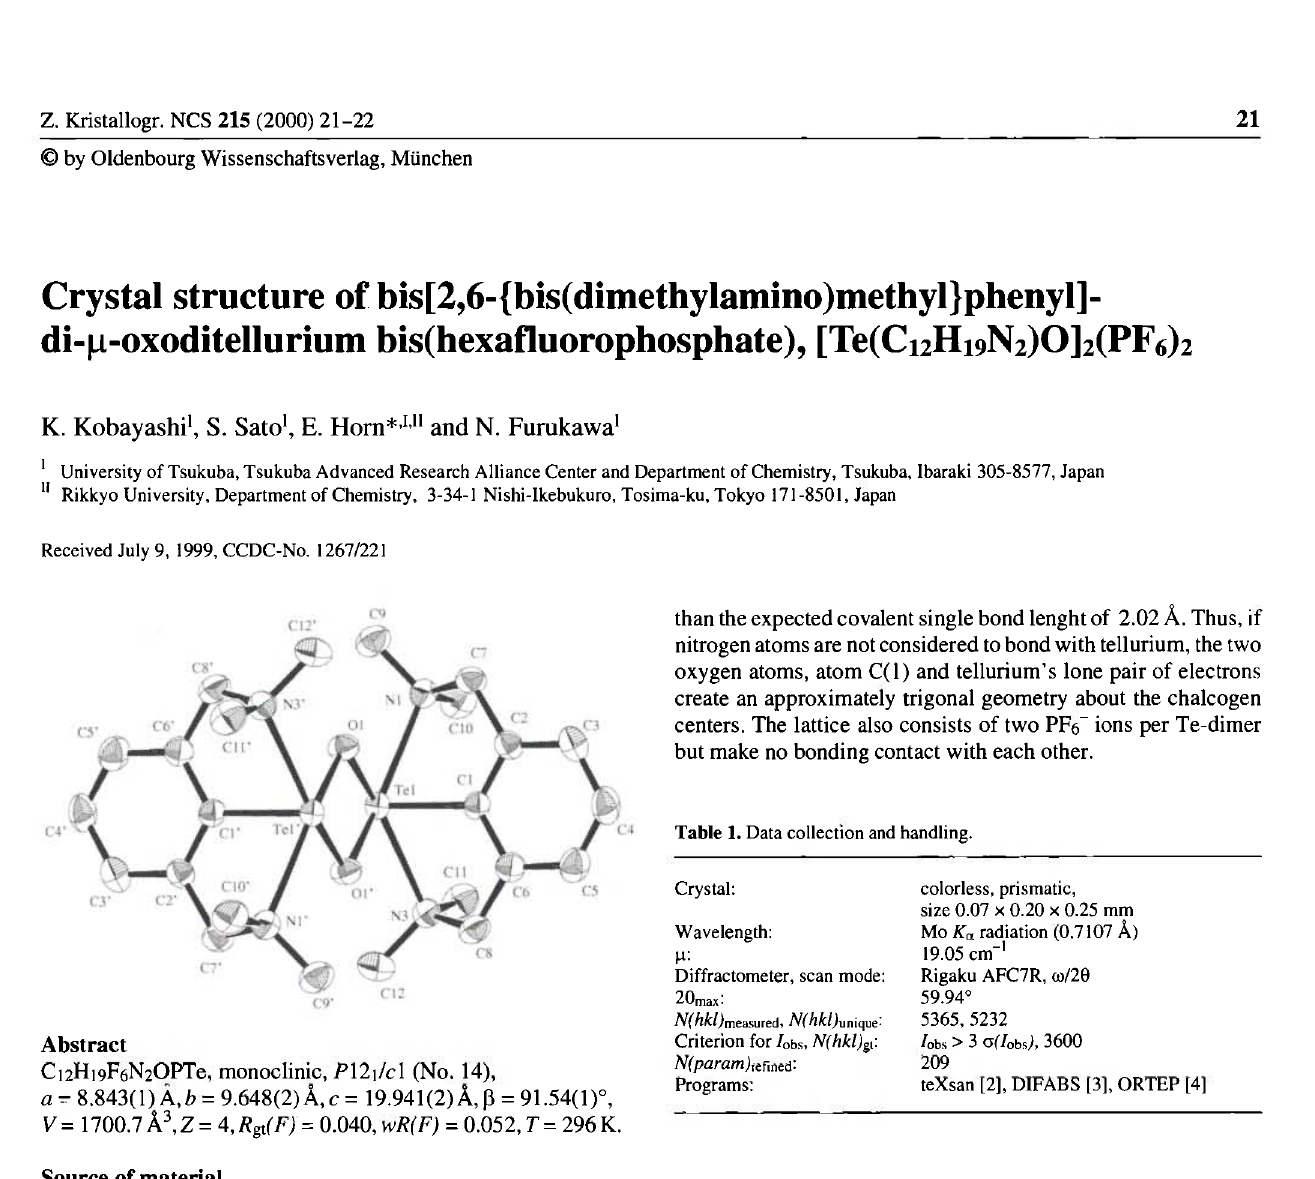
Table 2. Atomic coordinates and displacement parameters (in A 2